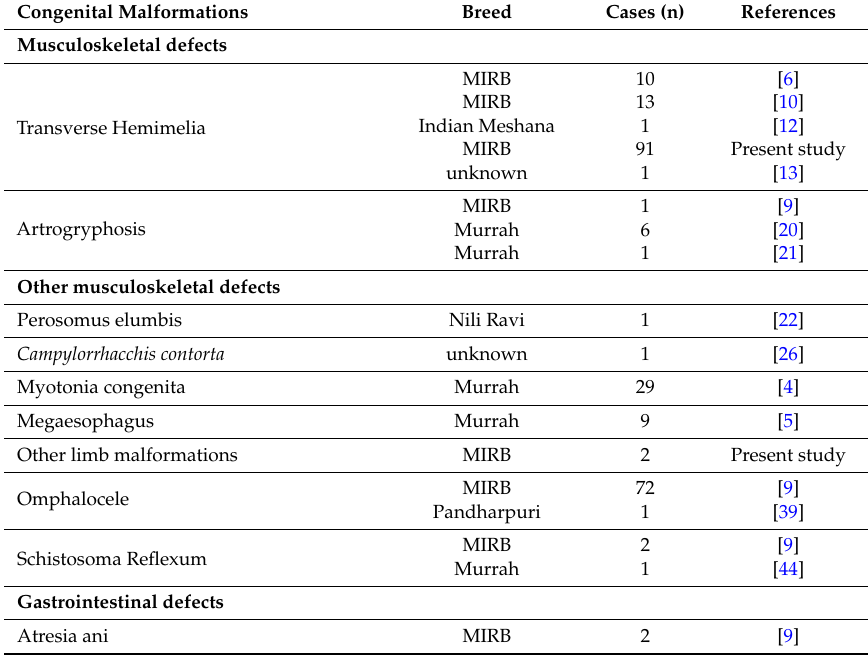
Table 1. Case number and types of congenital malformations reported in literature in different river buffalo